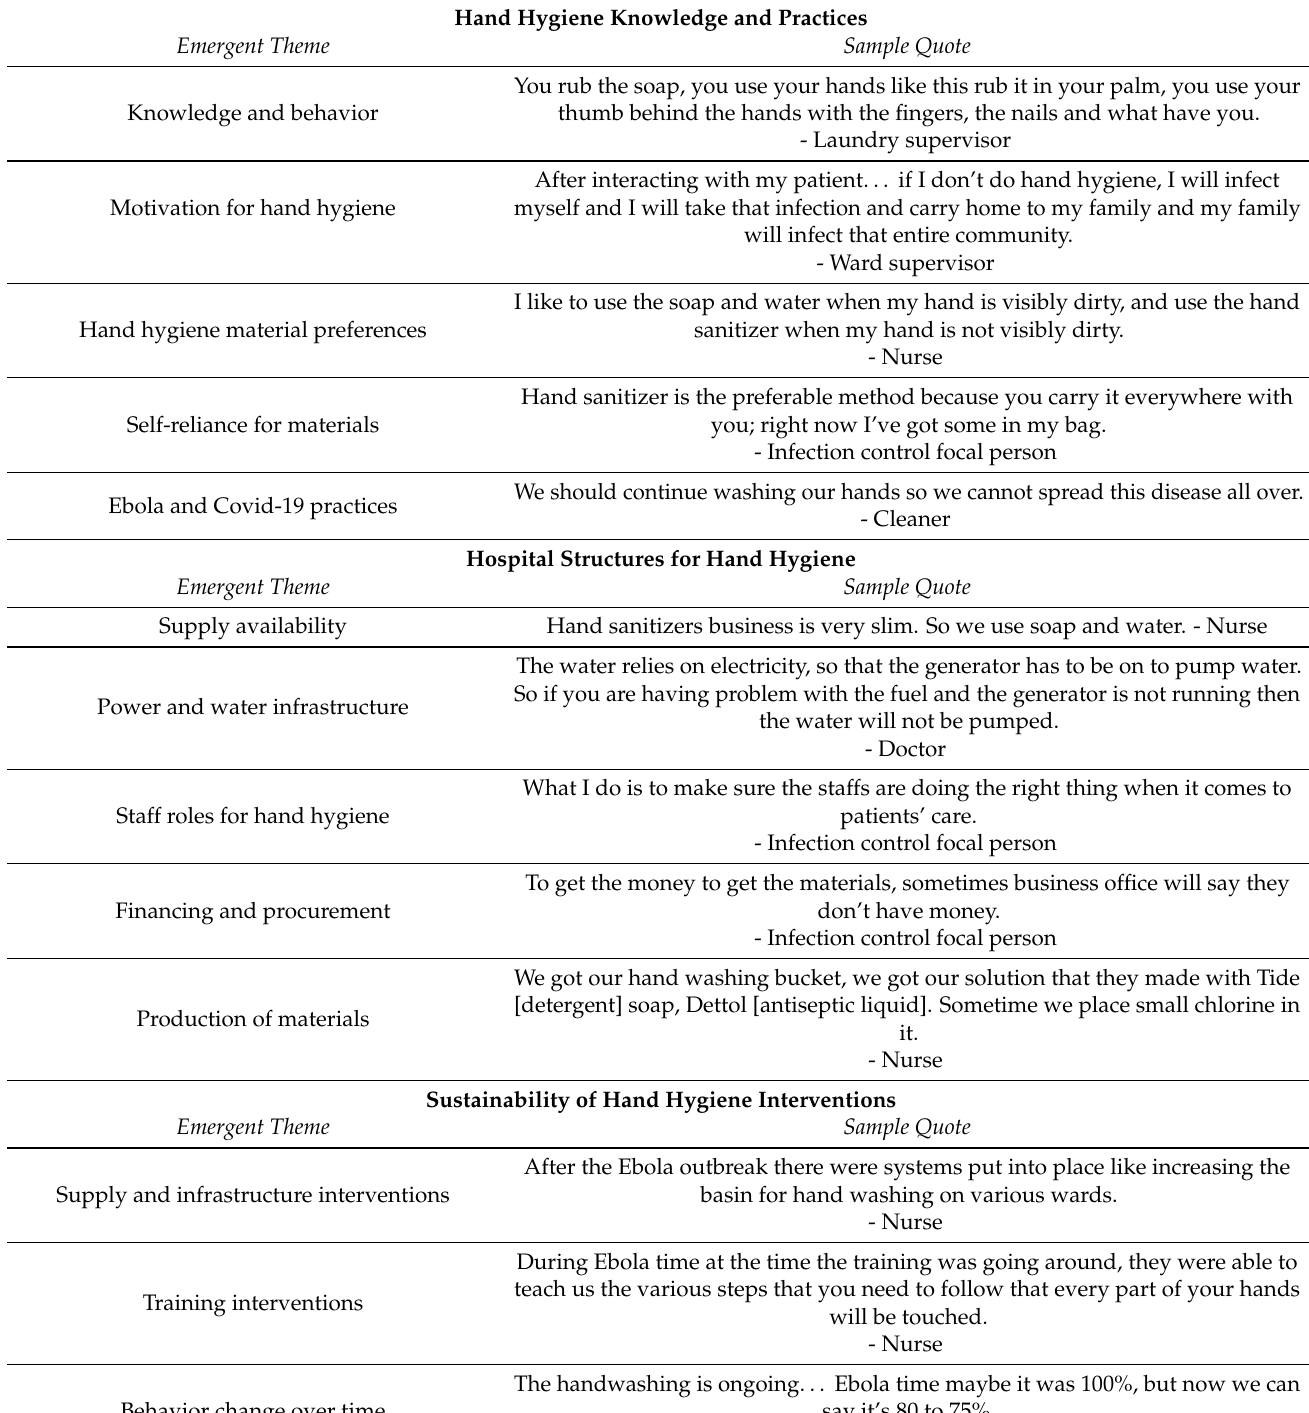
Table 4. Emergent themes and sample quotes from interviews with hospital staff in Liberia,